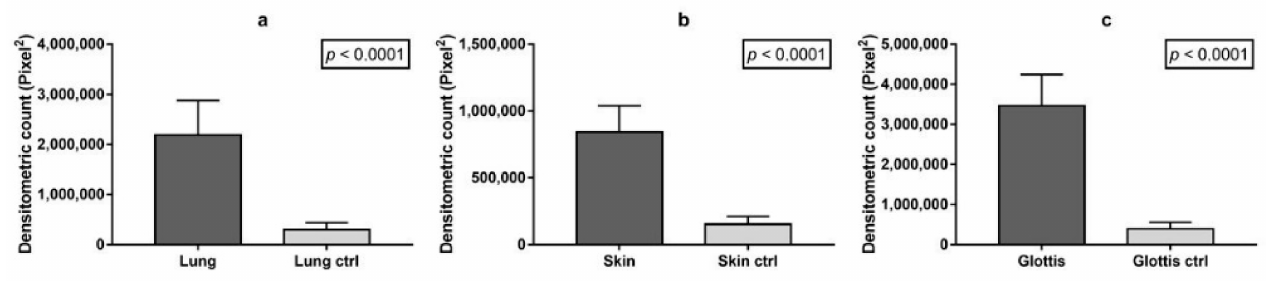
Figure 2. Comparison of the densitometric analysis (pixel 2 ) of the tryptase immunostained area expressed by positive, dark brown pixels in the analyzed fields for: ( a ) lung tissues ( n = 10) of cadavers who had died of anaphylactic shock vs. controls (ctrl); ( b ) skin tissue ( n = 8) of cadavers who had died of anaphylactic shock vs. ctrl; ( c ) glottis tissue ( n = 7) of cadavers who had died of anaphylactic shock vs. ctrl. Data are presented as mean ± standard deviation (SD) ( p < 0.05).